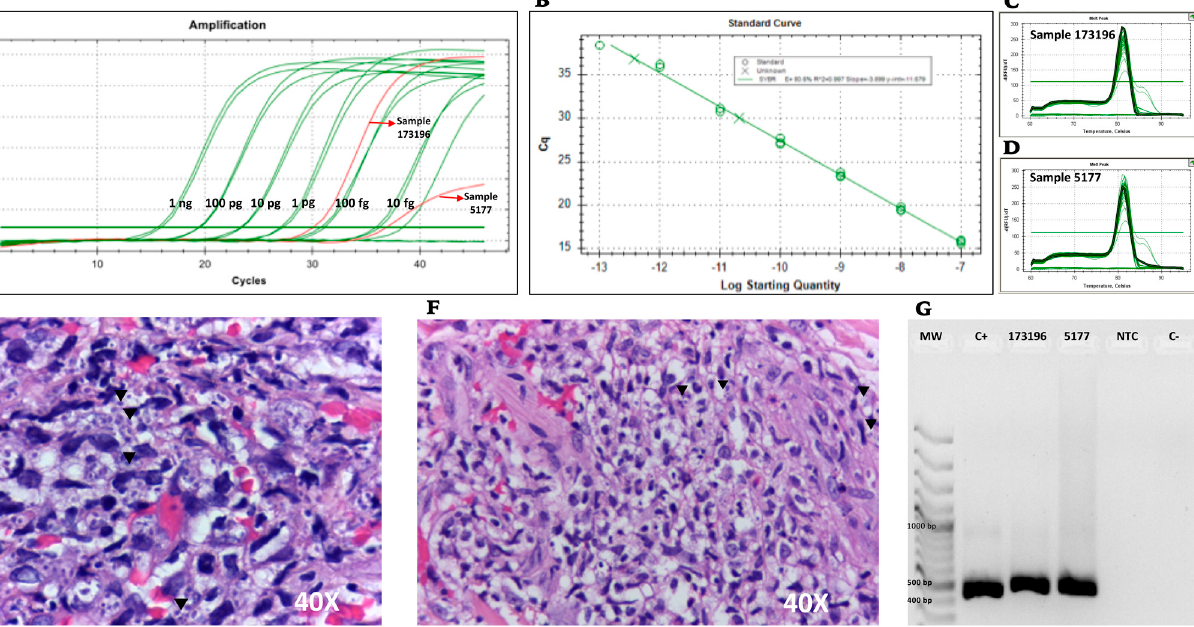
Figure 3. Detection of H. capsulatum DNA in FFPE skin tissue biopsies, qPCR, and melting curve analysis using PPK molecular target and histopathological stain. ( A ) qPCR amplification curves. ( B ) Standard curve. ( C , D ) Melting curve of PPK amplicons in clinical samples 173196 and 5177, respectively. ( E , F ) Microphotographs from skin biopsies stained with hematoxylin and eosin for samples 173196 and 5177, respectively. ( G ) Agarose gel electrophoresis of PPK conventional PCR amplification obtained from DNA extracted from FFPE skin biopsies. MW: molecular weight marker, C+: pCR2.1+PPK, NTC (nontemplate control), C-: human DNA.